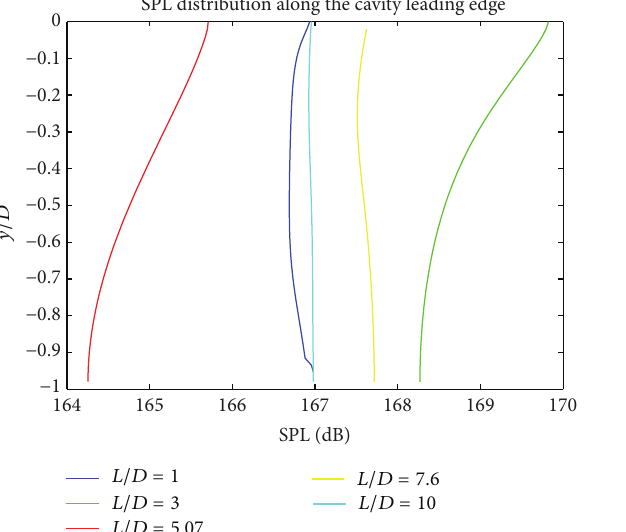
Figure 5: Sound pressure level distribution along the cavity leading edge.